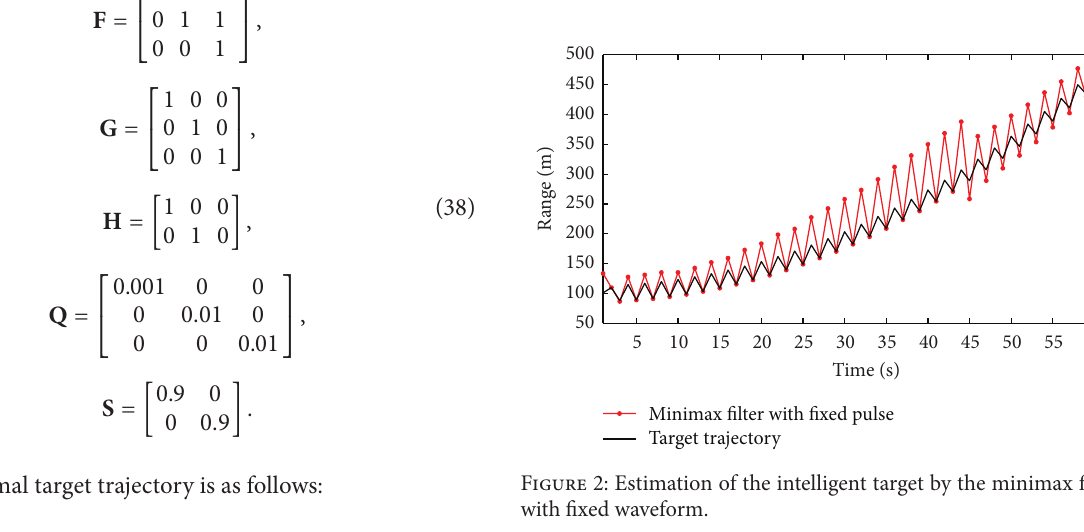
Figure 1: Estimation of the intelligent target by the minimax filter with selected waveform.